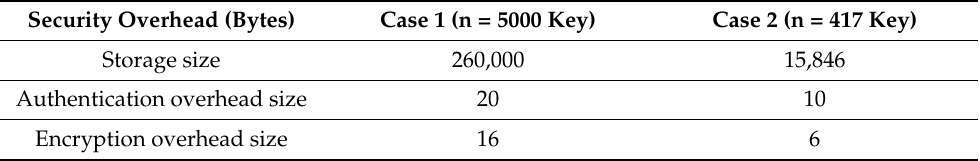
Table 6. The Security overhead of the proposed key mangment protocol at the end